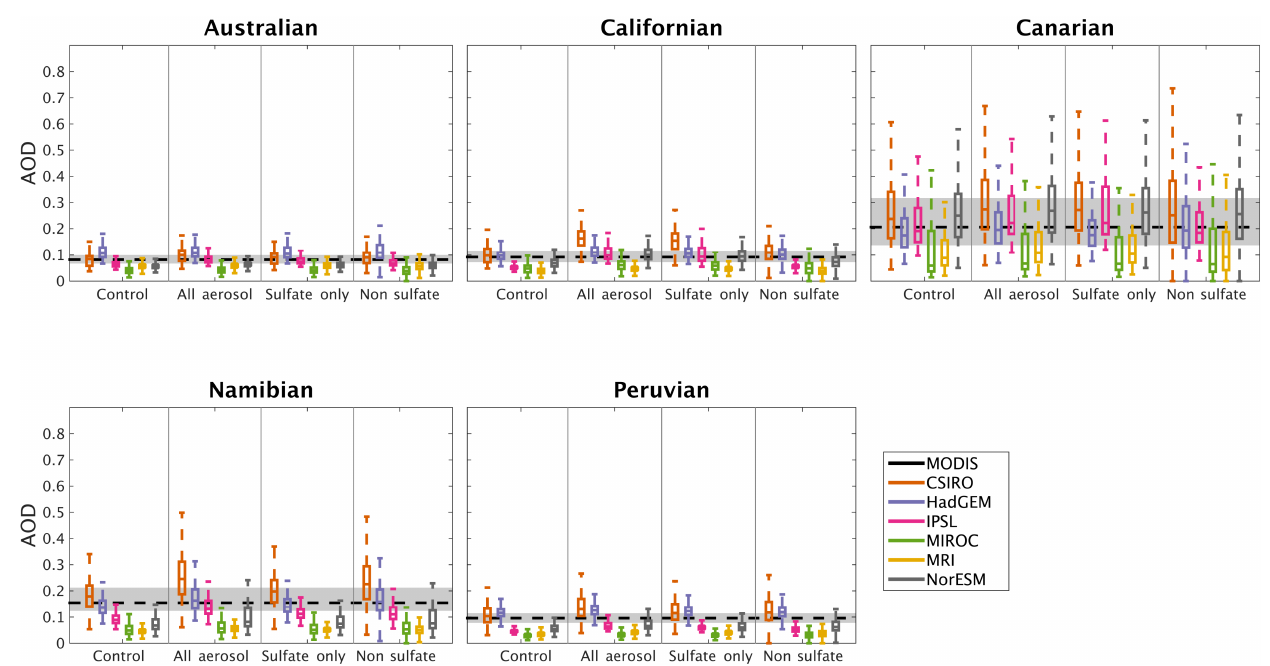
Figure 2. Box-and-whisker plots of total AOD for six CMIP5 models for the control, all-aerosol, sulfate-only, and non-sulfate cases in the Australian, Californian, Canarian, Namibian, and Peruvian regions. The median, 25th, and 75th percentiles and maximum and minimum AODs are indicated. The data are not de-seasonalized and not de-regionalized. The black dashed line indicates the median AOD value for MODIS satellite observations from 2002 to 2015, and grey shading shows the range between the 25th and 75th percentiles. Changes between the experiments are significant at the 5% level, except for two models in two different